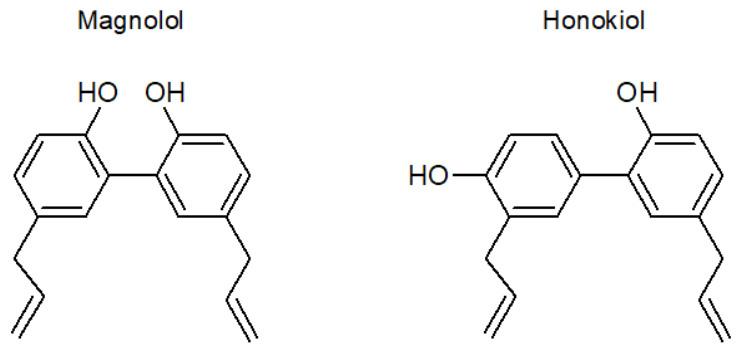
Figure 1. Structural formulas of magnolol and honokiol.